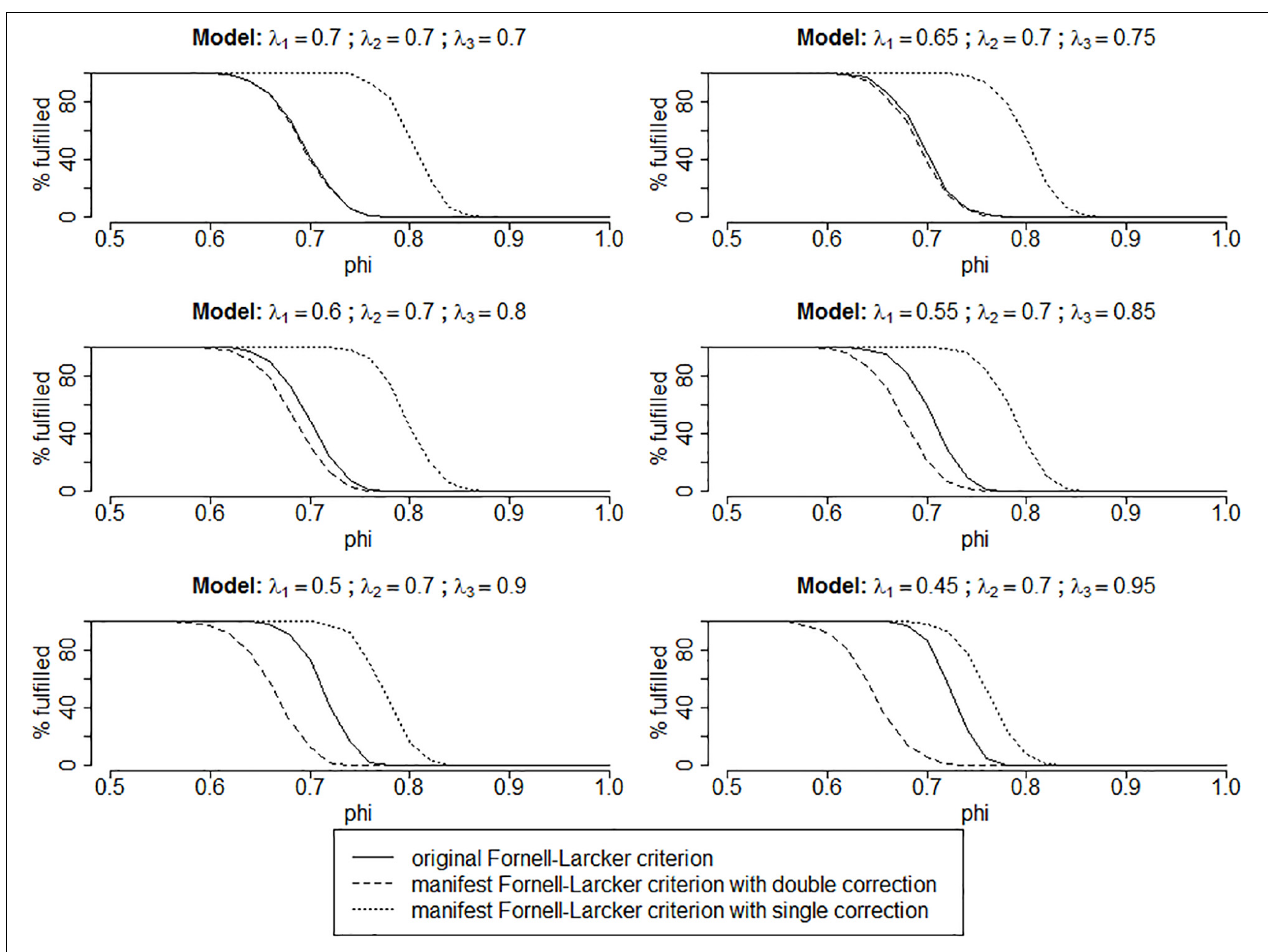
FIGURE 1 | Results of the simulation study for cases with n = 1,000. The results of the simulation runs with n = 250 are practically identical and therefore not shown here. Moreover, cases with ϕ xy < 0.5 are not shown since there are no violations of distinctiveness with the lambdas utilized in this simulation and none of the criteria proposed “detects” any violations